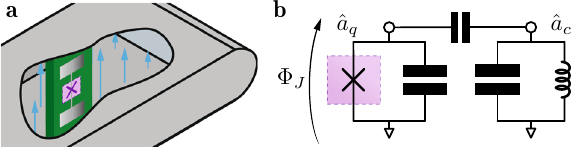
Fig. 1 Conceptual overview. a Illustration of the physical model of an example quantum device, which comprises two three-dimensional (3D) cavities (gray enclosures), each housing several qubit chips (green boxes). A close-up view of one of the chips is depicted in the inset. The dotted box in the center of the chip schematically outlines a nonlinear inductive sub-circuit, referred to as a Josephson dipole . b Results of a fi nite-element eigenmode analysis (FE e ) of the Josephson circuit linearized about its equilibrium. The m th mode eigenfrequency and electric (cid:6) (cid:7) (cid:6) (cid:7) ! ! ! ! and magnetic fi elds are ω m , E , and H , respectively, where r denotes spatial position. Center inset: E m r m r low) for the fundamental mode of one of the 3D cavities. Additional FE driven simulations (FE d ) are unnecessary; i.e., the impedance matrix Z jj 0 ω ð Þ is not calculated. c The Hamiltonian ^ H full , which includes nonlinear interactions to arbitrary order (see “ Results ” ), is computed directly from the eigenanalysis via the EPRs p mj and EPR signs s mj = ±1 of the junctions, j . Dissipative contributions due to a lossy element l are similarly computed from the loss EPRs p ml ; for linear dissipation, and the EPR signs s ml are unnecessary. Direct extraction of Hamiltonian and dissipative parameters from eigensolutions is unique to the EPR method. The geometry of the classical model is modi fi ed in an iterative search for the desired dissipative and Hamiltonian parameters (left-pointing arrow).